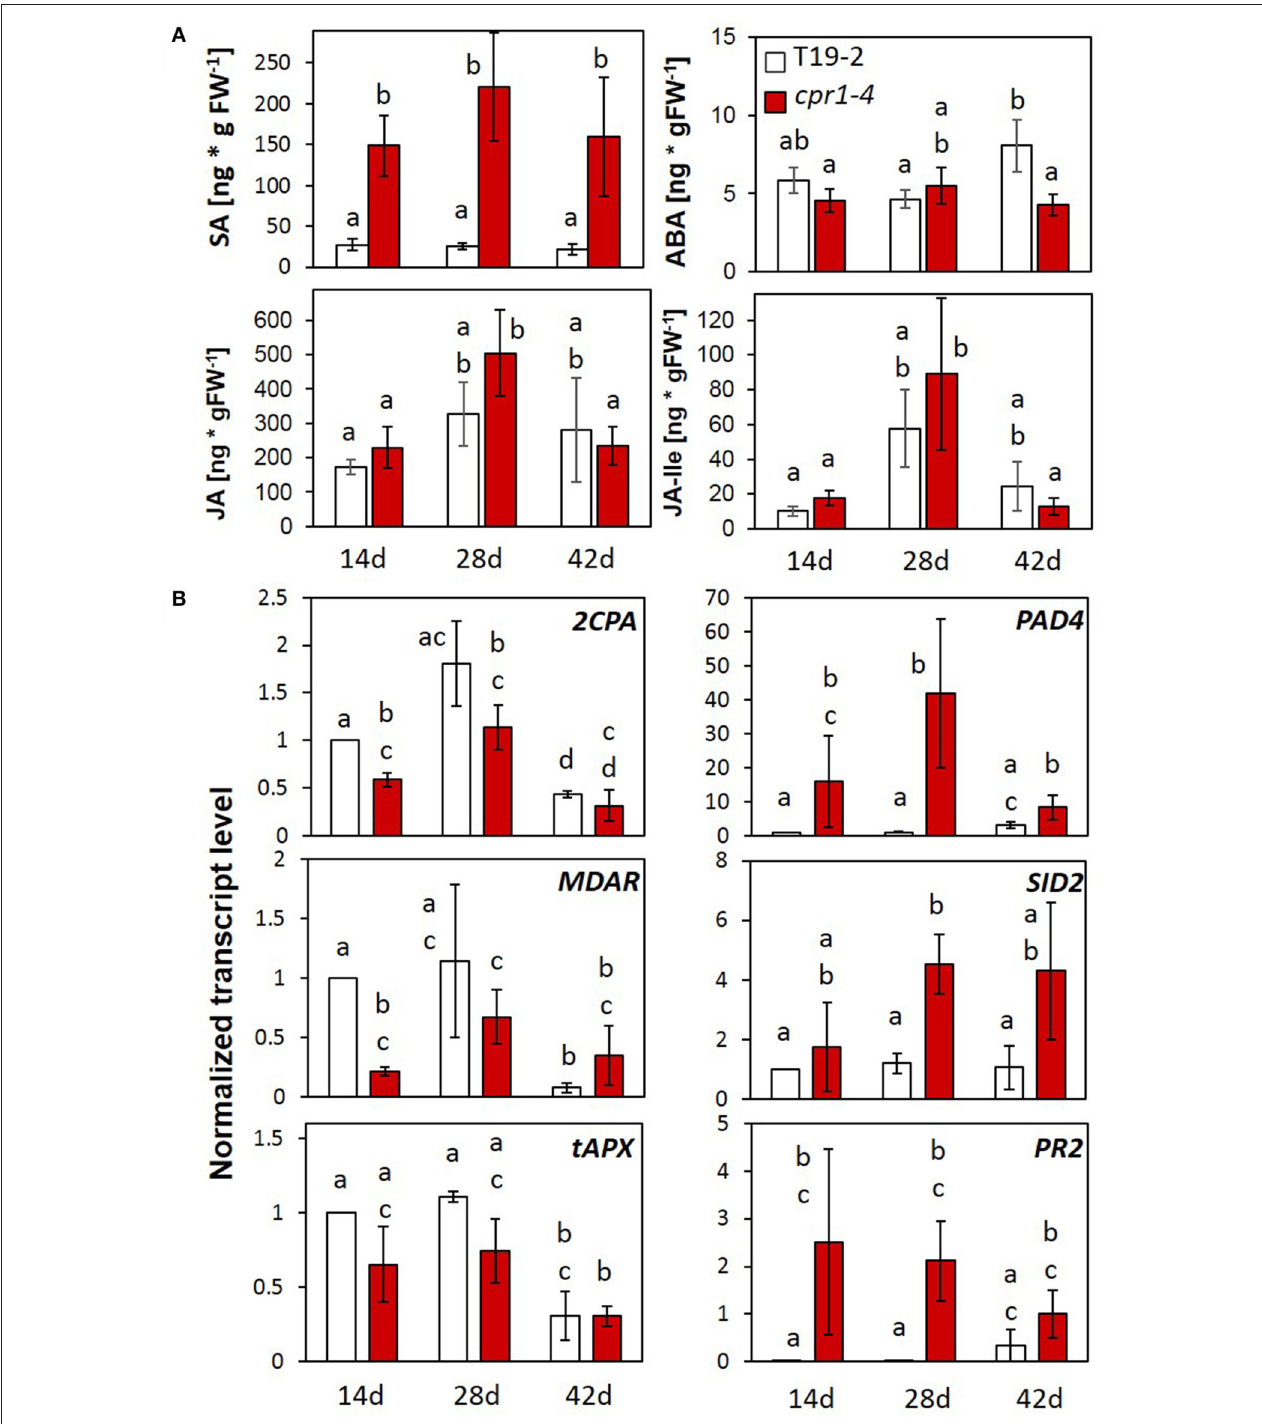
FIGURE 5 | Impact of CPR1 on the pathogen defense response and regulation of genes for chloroplast antioxidant enzymes during rosette development. (A) Total salicylic acid (SA), abscisic acid (ABA), jasmonate (JA) and jasmonate-isoleucine (JA-Ile) levels in 14-, 28-, and 42-day-old soil-grown cpr1-4 and T19-2 plants ( n = 6 biological replicates; Different letters show significance of difference; P < 0.05; pairwise Welch’s test). (B) Normalized transcript levels of genes for chloroplast antioxidant enzymes, and defense response marker genes of cpr1-4 and T19-2 plants during development [3 biological replicates, each measured in triplicate by qRT-PCR, normalized to At5g15710 ( F-box ) and At5g08290 ( YLS8 ) transcript levels. P < 0.05; ANOVA].